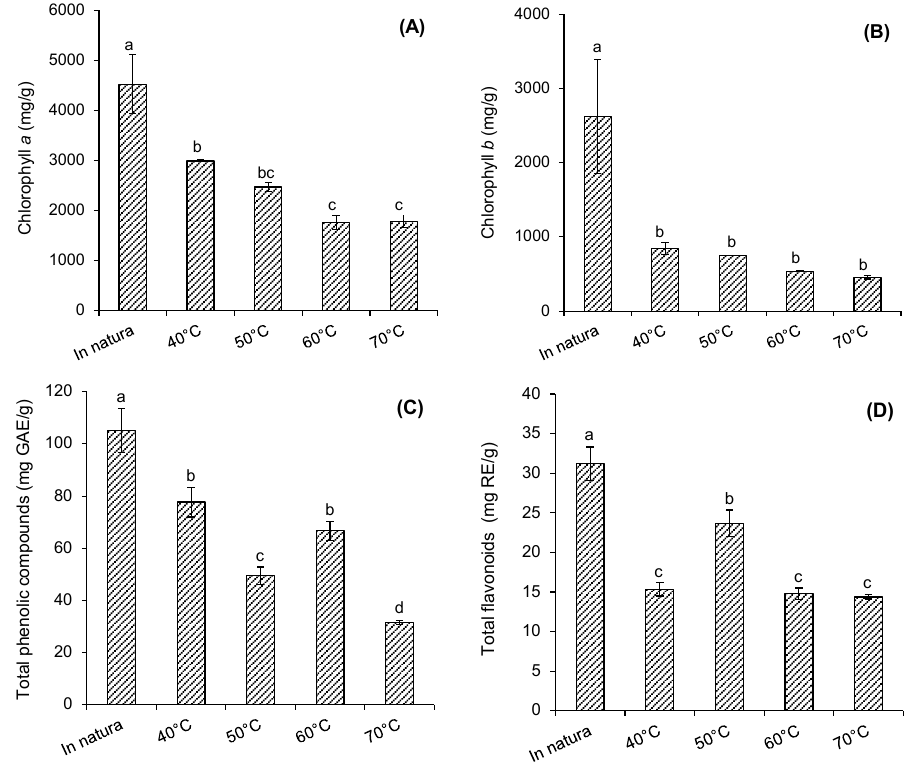
Figure 3. Behavior of chlorophyll, phenolic compounds, and flavonoids in fresh purple basil leaves and those dried at 40 °C, 50 °C, 60 °C, and 70 °C. ( A ) chlorophyll a (mg/g), ( B ) chlorophyll b (mg/g), ( C ) total phenolic compounds (mg GAE/g), and ( D ) total flavonoids (mg/g). Means with the same letters in the same graph do not differ statistically ( p ≤ 0.05) for Tukey’s test.